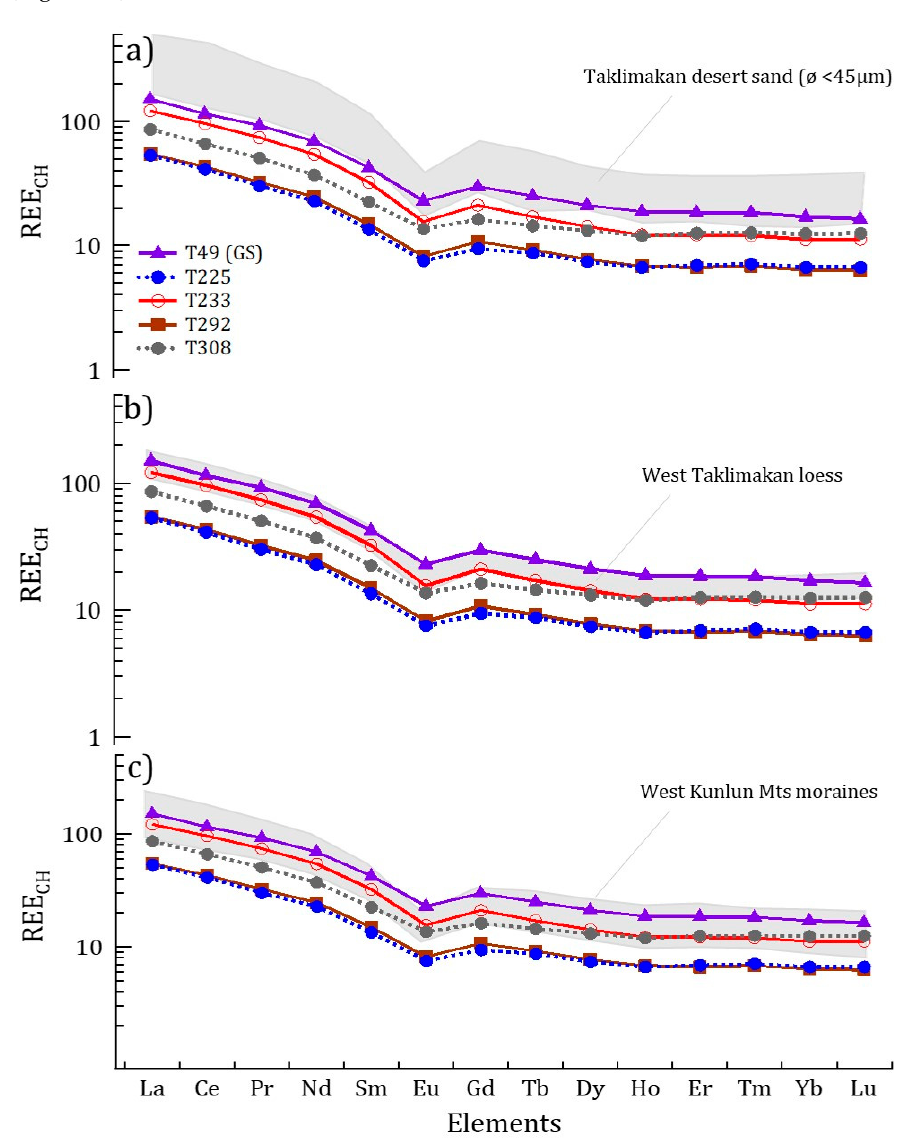
Figure 9. Chondrite-normalized REE patterns of dust filters from GS and GP ice cores compared to ( a ) Taklimakan fine desert sand, ( b ) West Taklimakan loess [36] and to ( c ) moraines of west Kunlun Mountains [92] represented by the shaded area. REE abundances in the C1 chondrite [93] are used for